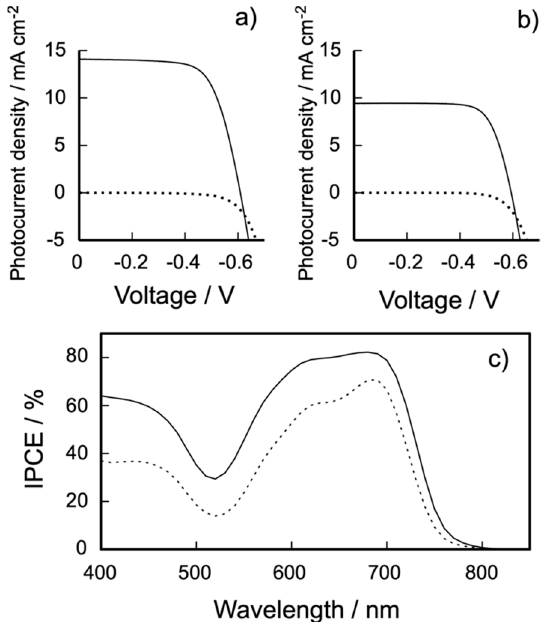
Figure 4. Photocurrent–voltage curves obtained with dye-sensitized solar cells (DSSCs) based on PcS27 ( a ) and PcS28 ( b ) under a standard global AM 1.5 solar condition (solid line) and darkness (dashed line); ( c ) incident photon-to-current conversion efficiency spectra for DSSCs based on PcS27 (solid line) and PcS28 (dashed line). Energies 2020 , 13 , x FOR PEER REVIEW